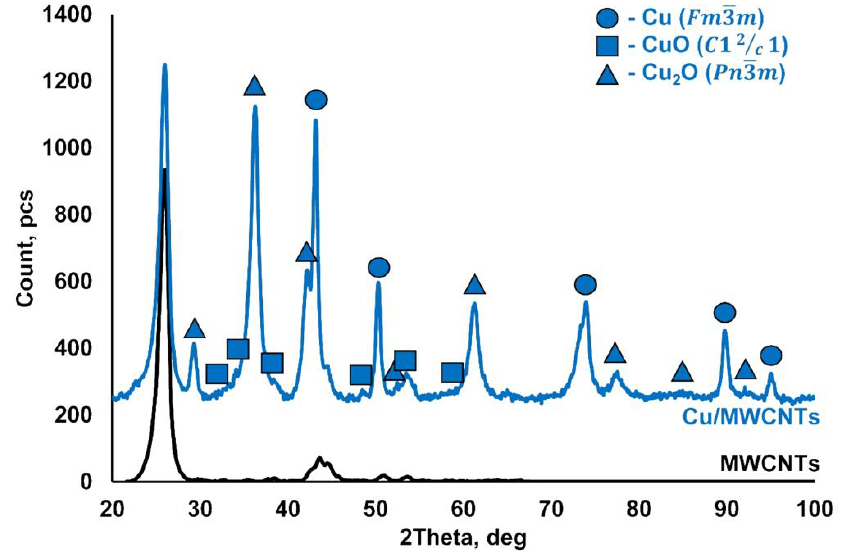
Figure 3. Powder XRD patterns of the initial MWCNTs (black) and Cu/MWCNTs hybrid nano- composite (blue). posite